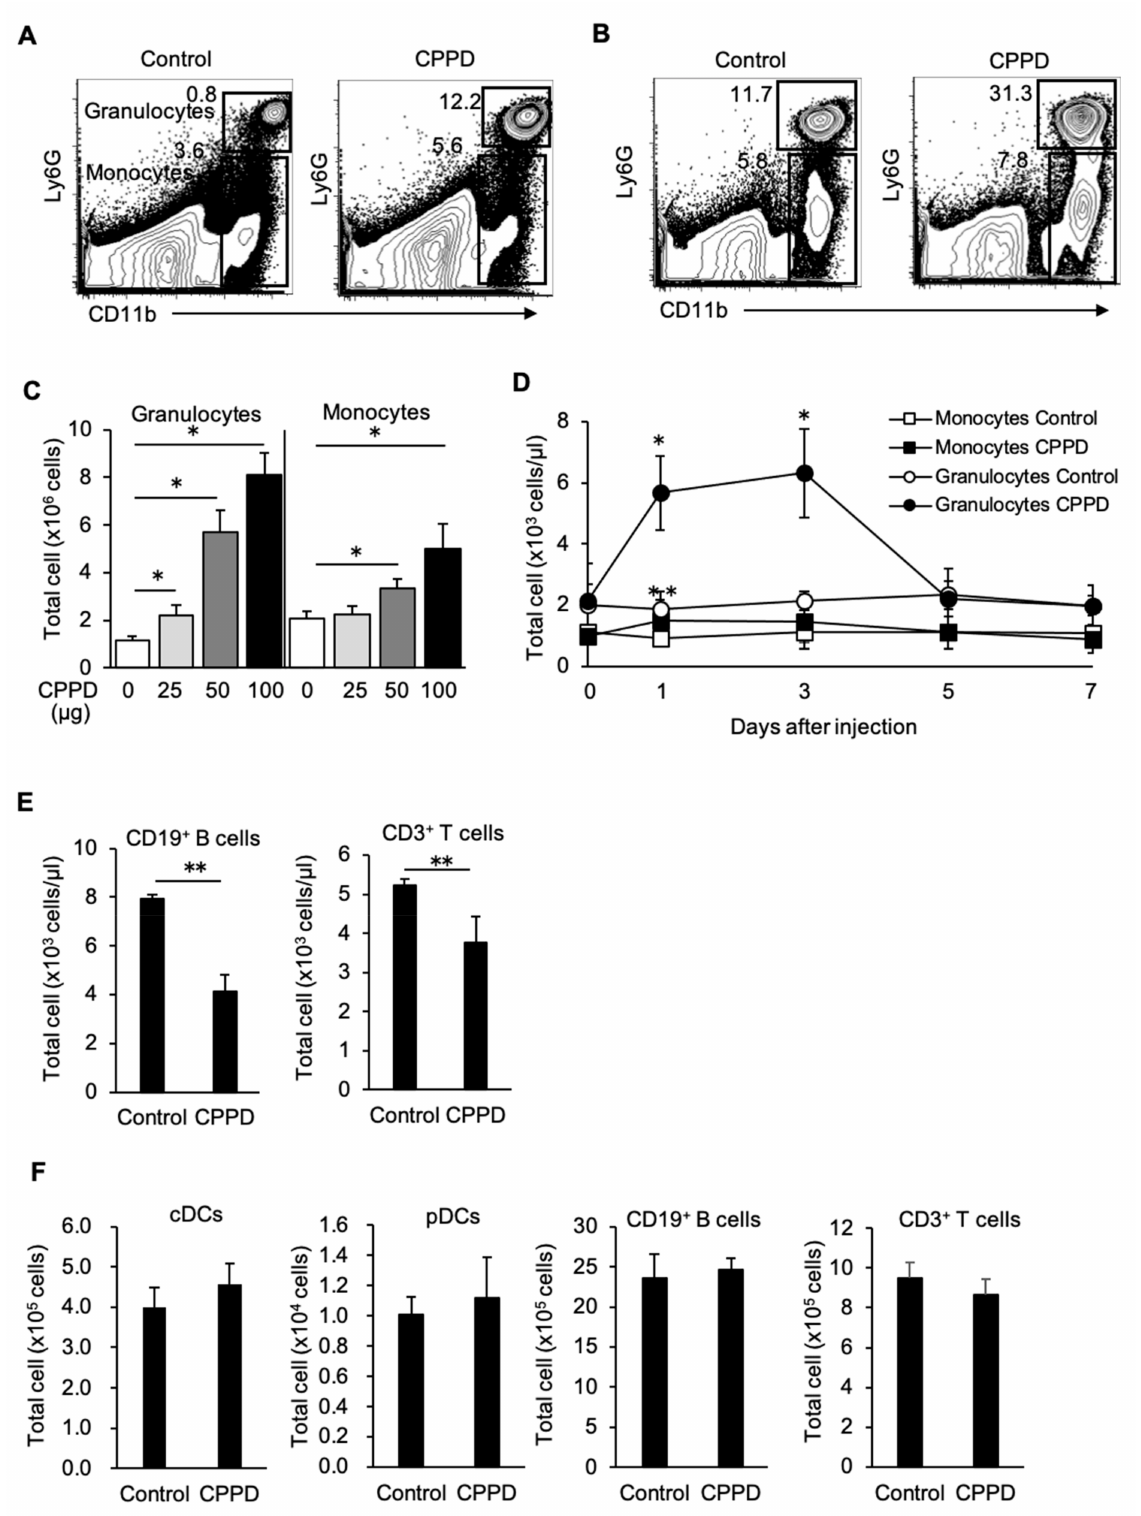
Figure 2. CPPD injection induces myeloid cell expansion in vivo. ( A,B ) The percentage of granulocytes (Ly6G + CD11b + ) and monocytes (Ly6G int CD11b + ) in the spleen ( A ) and peripheral blood ( B ) of the mice 3 days after the CPPD injection. ( C , D ) The total cell number of granulocyte and monocytes in the spleen ( C ) and PB ( D ) after CPPD injection of the indicated dose and at the indicated time course. ( E , F ) Total cell number of CD19 + B cells, and CD3 + T cell in the peripheral blood (E ) and conventional dendritic cells (cDCs), plasmacytoid DC (pDC), and CD19 + B cells, and CD3 + T cells in the spleen ( F ). Data represent the mean ± s.d. of three independent experiments. * p < 0.01, ** p <